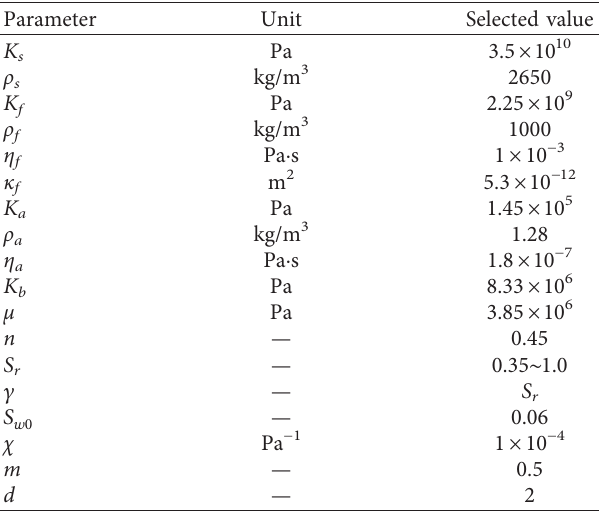
Figure 3: Distributions of the vertical displacement of solid particles u compared to those reported by Schanz and Cheng [17]. (a) u z . (b) p f . Table 1: Unsaturated soil specification. Parameter